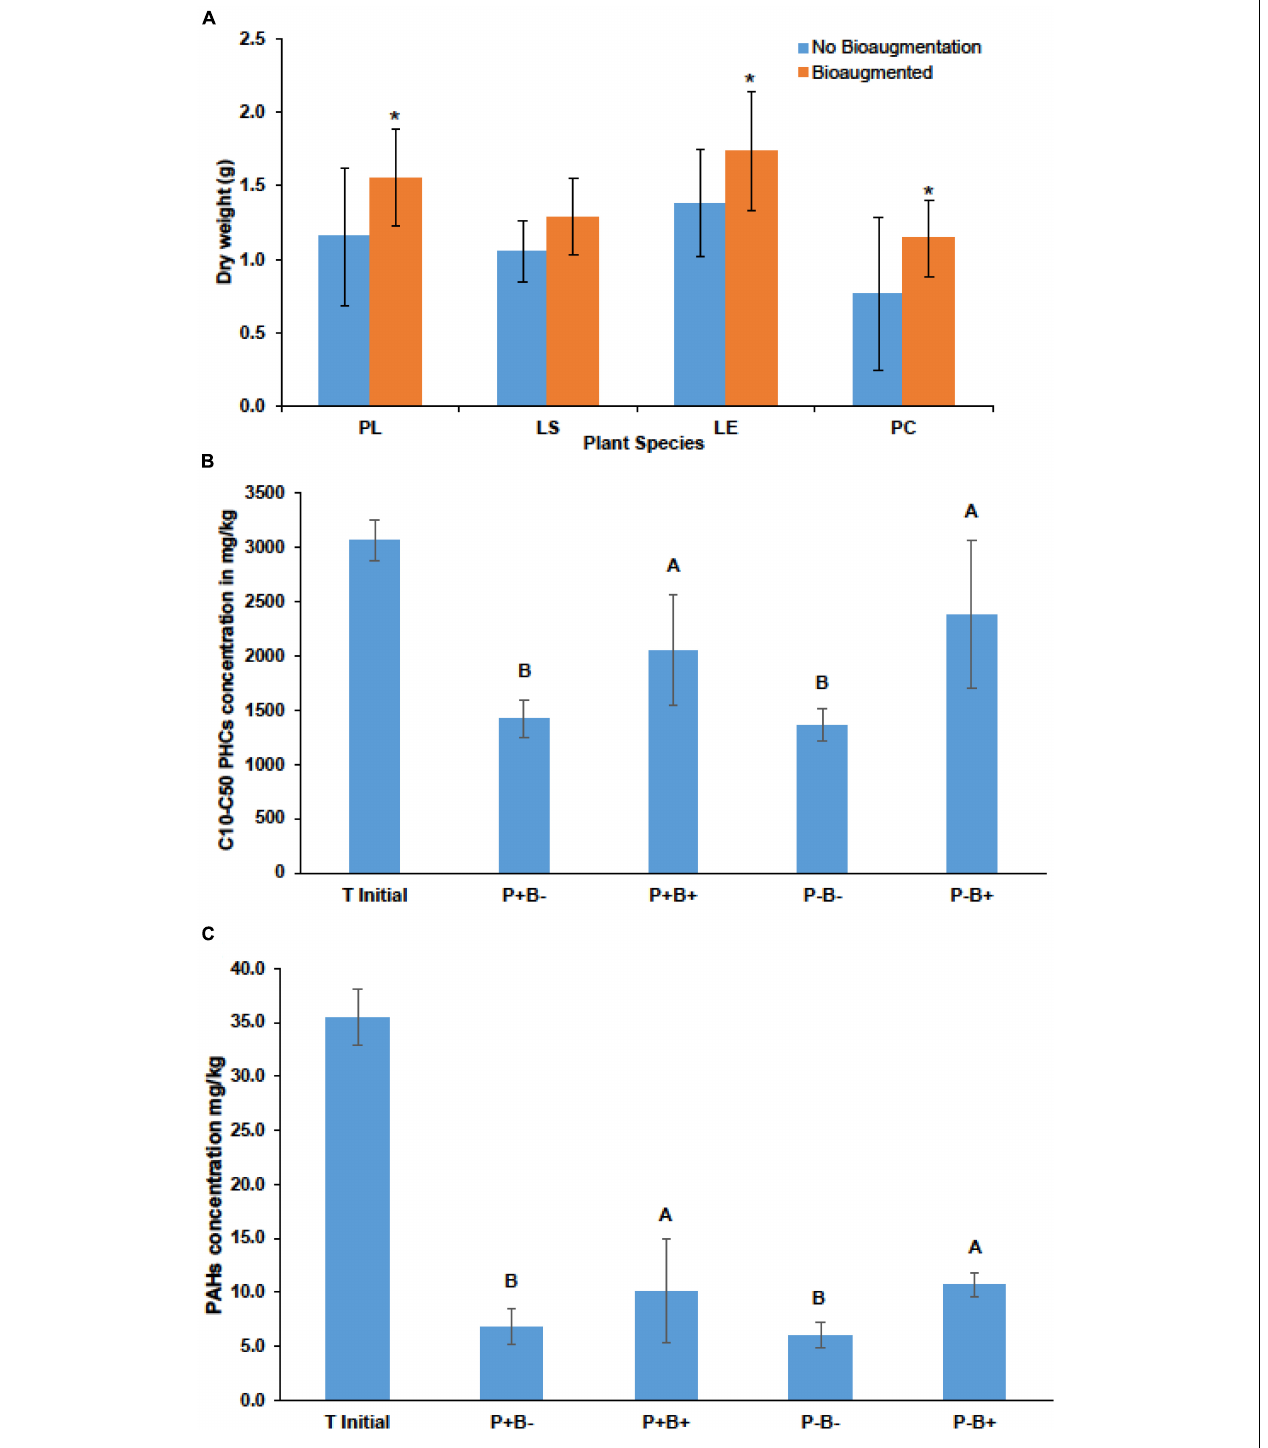
FIGURE 3 | (A) Effect of bioaugmentation on average plant shoot dry biomass for each species at the end of the experiment. Errors bars are standard deviation. PL, Persicaria lapathifolia ; LS, Lythrum salicaria ; LE, Lycopus europaeus ; PC, Panicum capillare . N = 12 for each species. Average dry weights for each species were compared with or without bioaugmentation using a Student’s T -test. Asterisks indicate that the dry weight was significantly different between treatments. (B) Average remaining concentration in the sediments of C10–C50 aliphatic hydrocarbons in each treatment. (C) Average remaining polycyclic aromatic hydrocarbons (PAHs) at the end of the experiment. Errors bars represent standard deviation. N = 4 for each treatment. For (B,C) plantation and bioaugmentation effects were tested using a two-way full factorial ANOVA in JMP v.7. Treatments not sharing the same letter are significantly different. We added the initial value for reference.